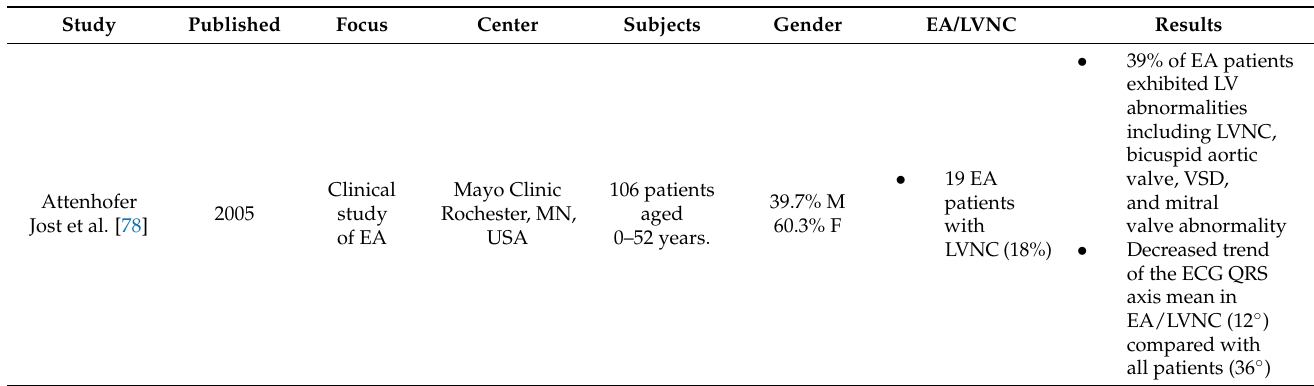
Table 3. Clinical Studies that discuss